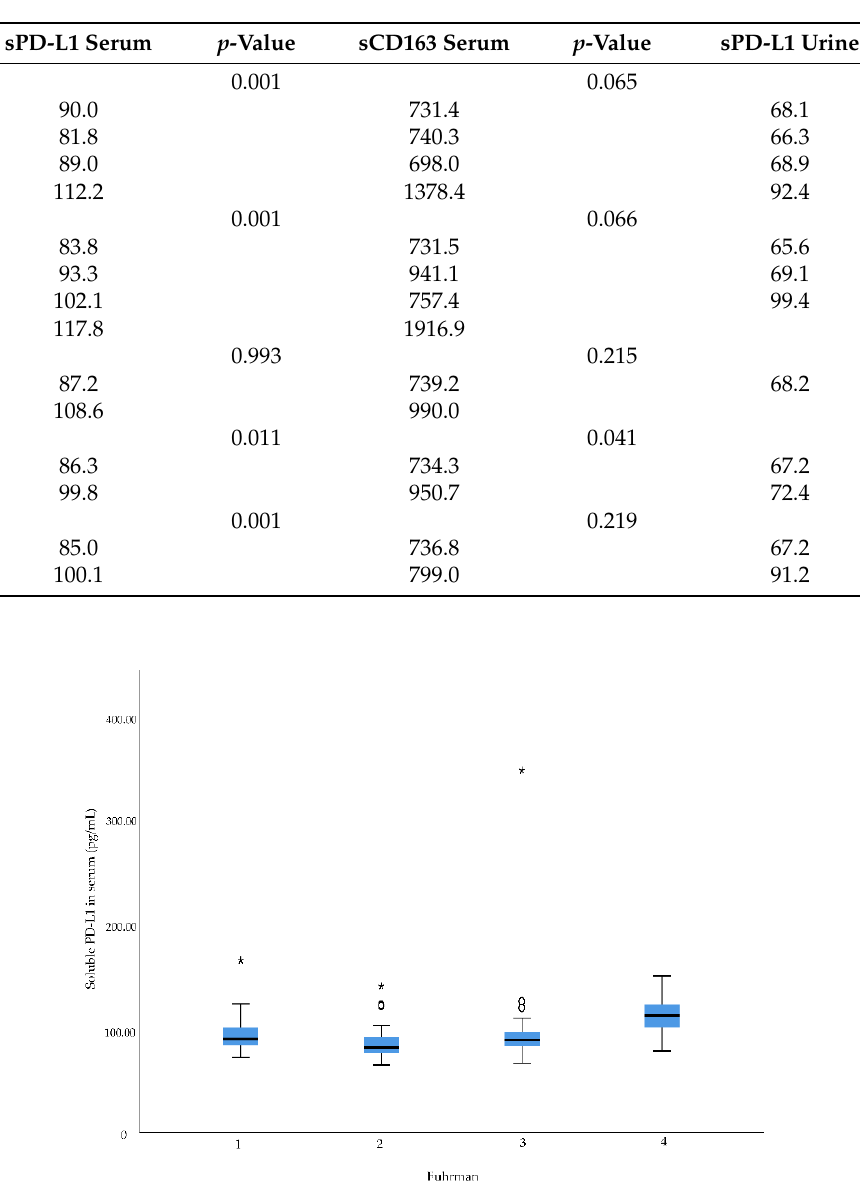
Table 2. Associations between median levels of soluble PD-L1 and CD163 in serum and urine and clinico-pathological characteristics in patients with renal cell carcinoma.